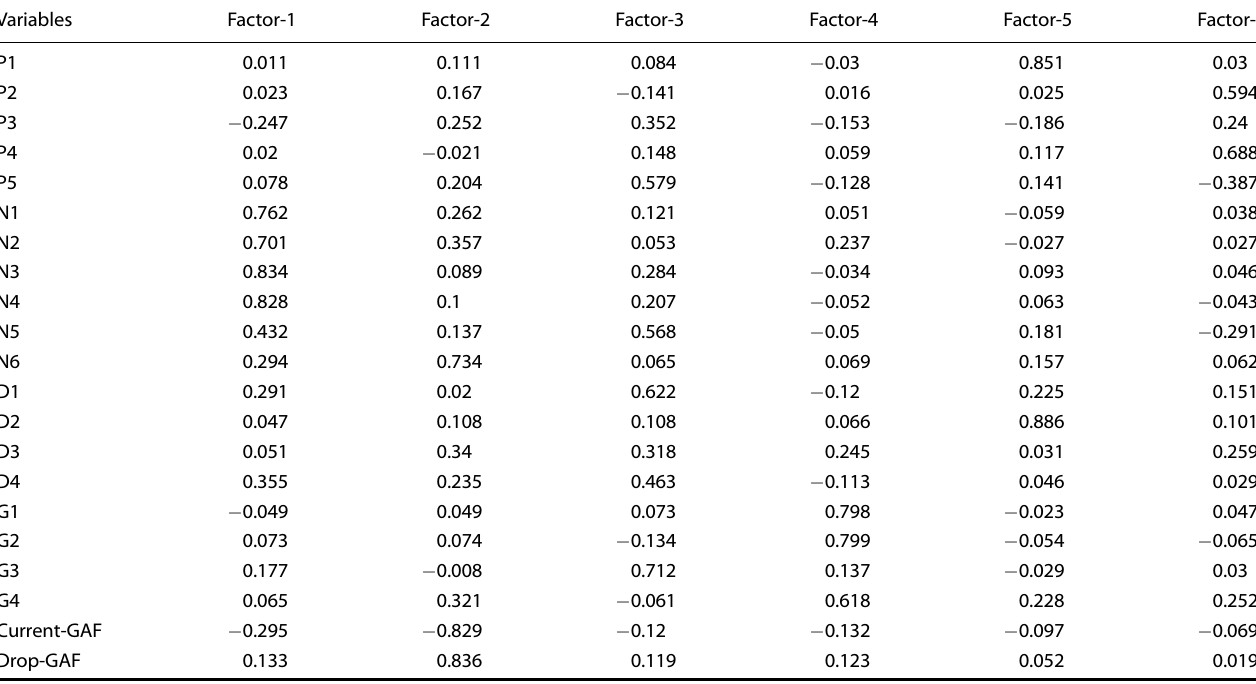
Table 2. Standardized factor loadings obtained from exploratory factor analysis, using varimax rotation, of 14 clinical items and two GAF (Global Assessment of Functioning) scores from the SIPS ( N = 600).